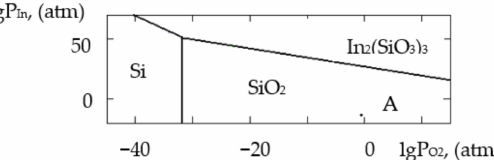
Figure 3. PPD in In–Si–O system at temperature T = 873 K within lgP O2 –lgP In coordinates.